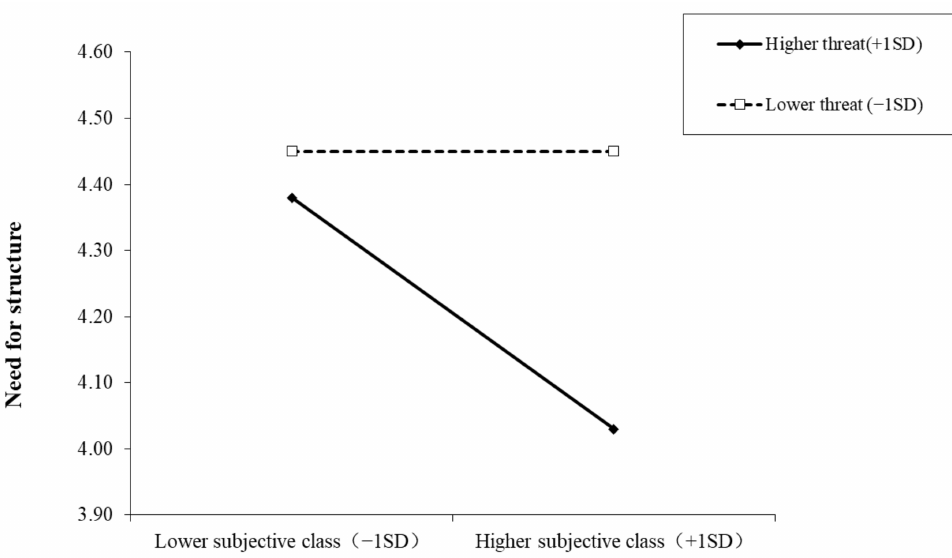
Figure 6. Interactive effect of pandemic threat and subjective social class on need for structure. Note: Pandemic threat is graphed for two levels: high pandemic threat (1 SD above the mean) and low pandemic threat (1 SD below the